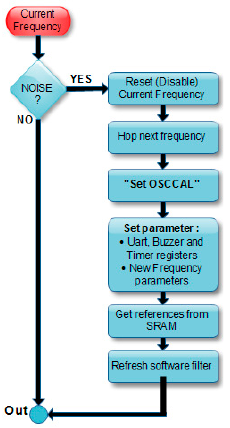
Figure B4. The flowchart of the frequency_handler.